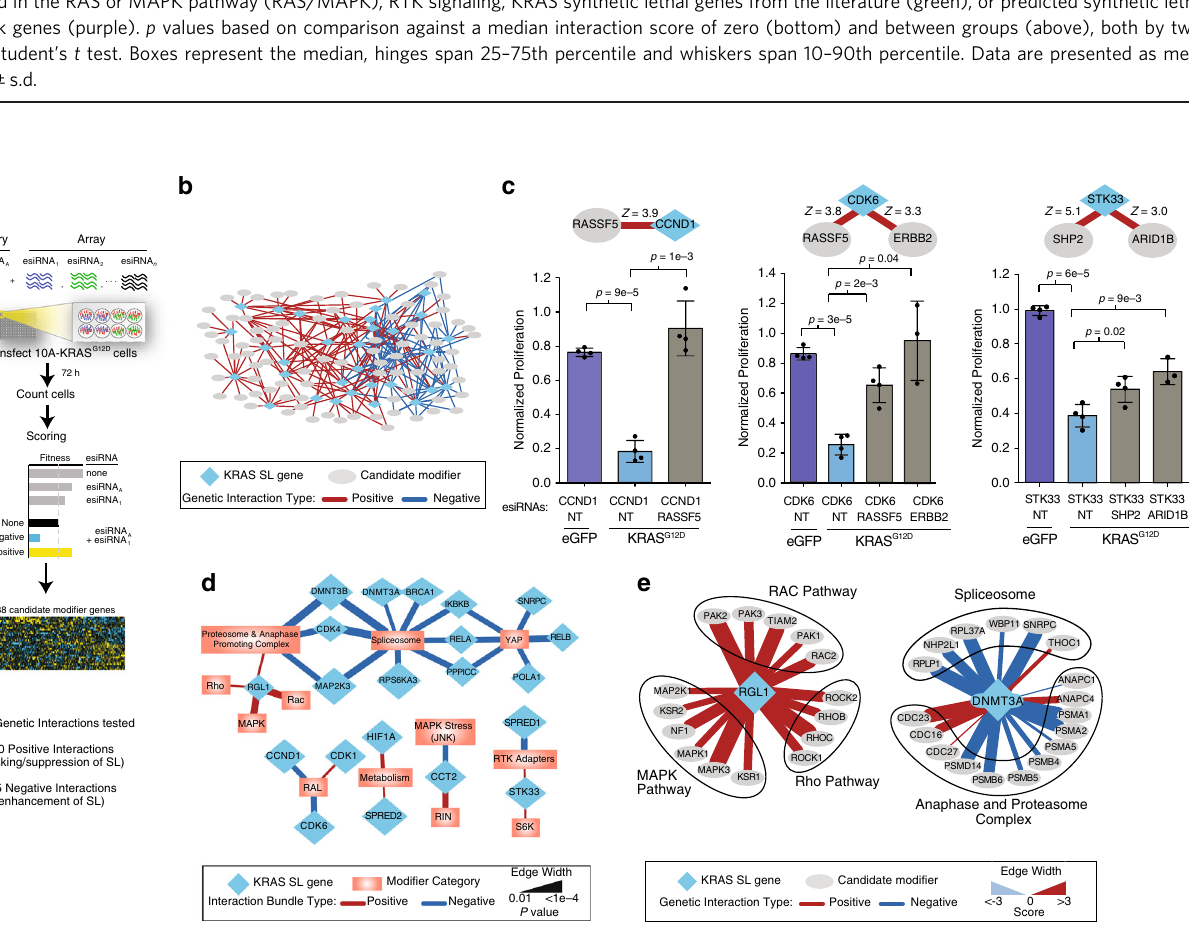
Fig. 4 A genetic interaction map identi fi es KRAS synthetic lethal suppressors. a Overview of approach to generate an epistatic mini-array pro fi le (E- MAP) using combinatorial RNAi to measure 5828 pairwise genetic interactions in MCF10A KRAS G12D cells grown in minimal media. esiRNAs targeting a set of genes are arrayed in a pairwise fashion (in quadruplicate) in tissue culture plates. Reverse transfection is then performed, and the resulting fi tness defects are observed using high-content imaging. Raw data are normalized and scored (see Methods). b Overview of genetic interaction map for 30 KRAS synthetic lethal genes and candidate modi fi ers. Interactions scoring >2 (red) or < − 2 (blue) are shown. c Relative proliferation of knockdown of three KRAS synthetic lethals identi fi ed or con fi rmed in this study, CCND1, CDK6 and STK33, in eGFP or KRAS G12D MCF10A cells alone and in combination with their top positive interaction partners. Proliferation normalized to mock. p values based on a two-sided t test, Data are presented as mean values ± s.d. n = 4 biologically independent samples. d Categorical annotations for groups of genes displaying signi fi cantly strong genetic interactions with synthetic lethal query genes with p < 0.01 based on two-tailed Student ’ s t test (see Methods). Edge width is proportional to signi fi cance. e Genetic interaction partners involving two KRAS synthetic lethal genes identi fi ed in this study, RGL1 and DNMT3A, and associated pathways enriched for genetic interactions. Edge thickness is proportional to interaction identi fi ed in our single gene study (query genes) in combination with 188 genes mostly involved in the broader RAS signaling produce a stronger phenotype than expected 33 . We generated an pathway (Fig. 4a, Supplementary Data 8). Together, we measured interactions among 5828 gene pairs and identi fi ed 170 positive and 105 negative interactions at a score cutoff of 2 ( Z > |2|)